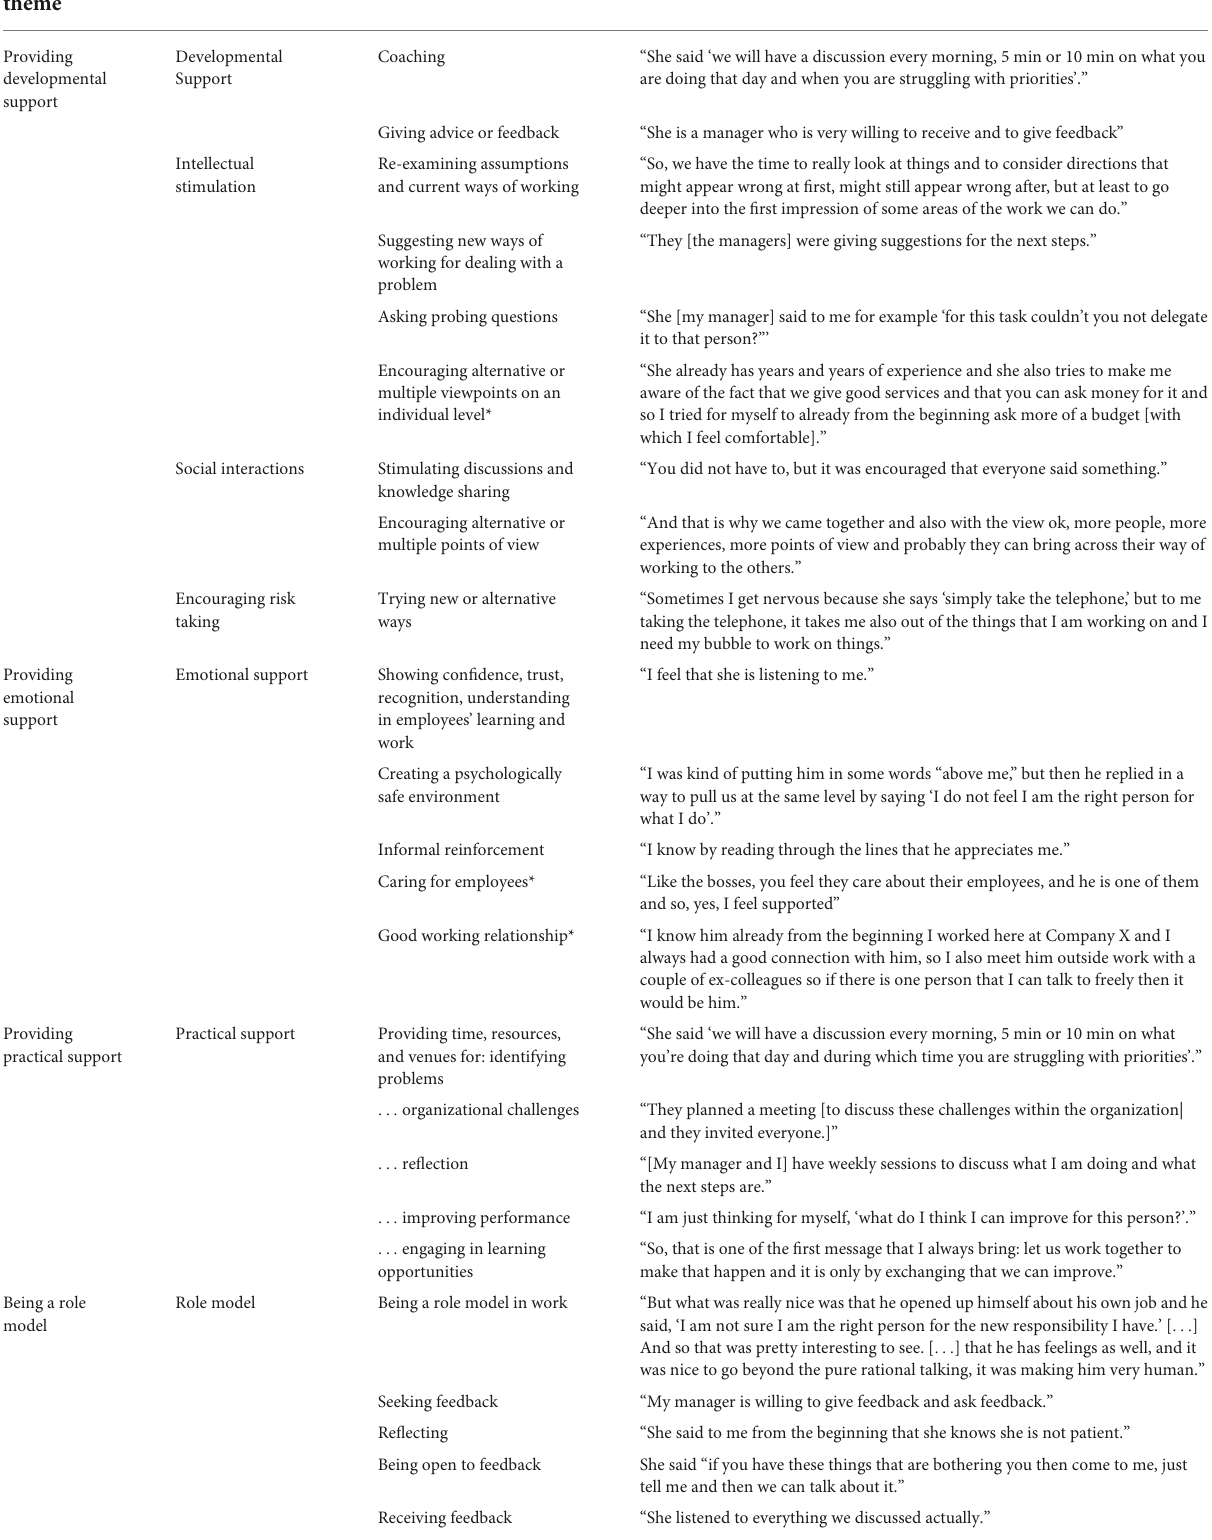
TABLE 2 Coding scheme for learning